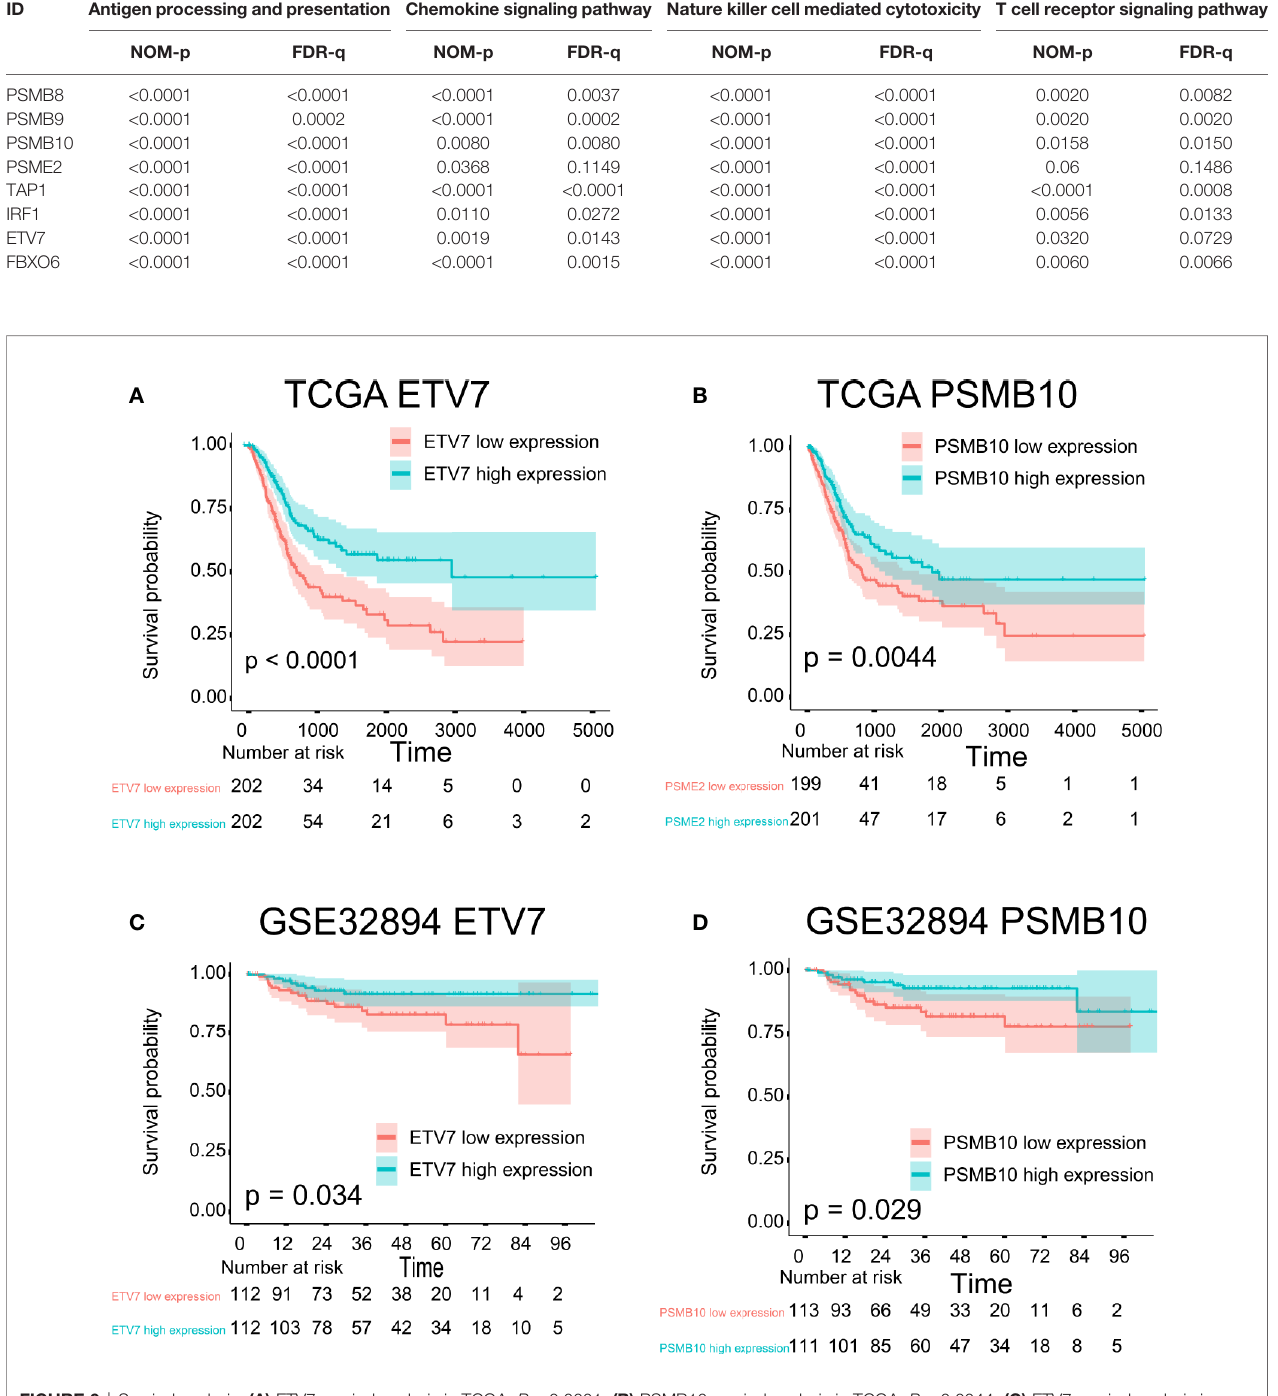
FIGURE 9 | Survival analysis. (A) ETV7 survival analysis in TCGA, P < 0.0001. (B) PSMB10 survival analysis in TCGA, P = 0.0044. (C) ETV7 survival analysis in GSE32894, P = 0.034. (D) PSMB10 survival analysis in GSE32894, P =